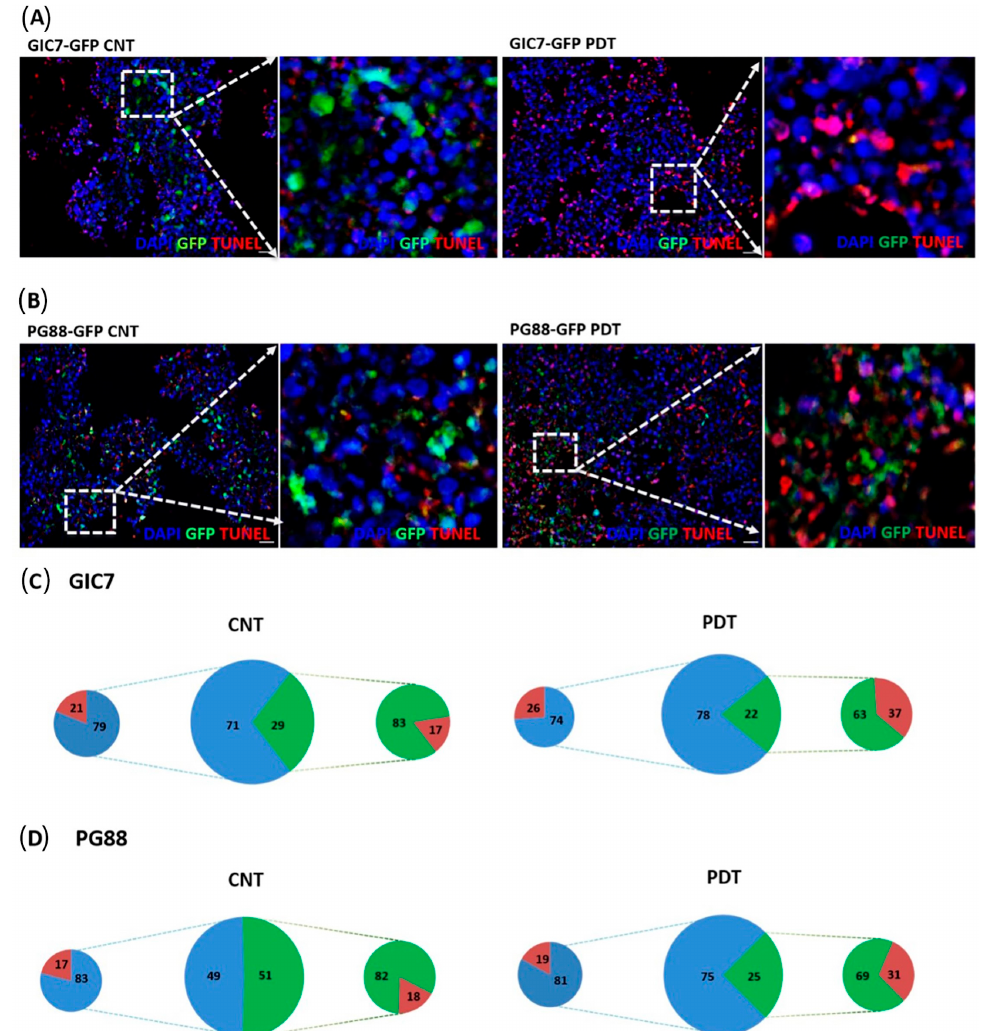
Figure 9. Tunel analysis of GFP-GICs and organoid co-culture. Tunel of GIC7-organoid co-cultures ( A ) and PG88-organoid co-cultures with 5-ALA ( B ) no treated (CNT) (left panels) or treated (right panels) with photodynamic therapy (50 µg/mL with 5-ALA, 1.2 J/cm 2 irradiation). At 20× (big squares), the scale bar is 20 µ m. 5-ALA controls (GIC7-GFP CNT or PG88-GFP CNT) without PDT and PDT-treated (GIC7-GFP PDT or PG88-GFP PDT) visualizing the red TdT-DIG-rhd cells and apoptotic bodies accumulated more in treated tissue at the tumor areas (green fluorescent cells) than in 5-ALA-controls (blue). Few apoptotic cells were scattered in non-infiltrated brain-organoid tissue (blue) in both 5-ALA-control and PDT-treated co-cultures. Blue DAPI-stained nuclei were used to counterstain cells. Semi-quantitative analysis of samples: GIC7 5-ALA CNT, 12 fields from 2 samples; GIC7 PDT-treated, 19 fields from 3 samples; PG88-5-ALA CNT, 7 fields from 2 samples and PG88 PDT-treated, 17 fields from 3 samples, was done. Semi-quantitative analysis is represented as a percentage average of positive cells on ( C, D ) pictures: green color (GFP-GICs cells), blue organoid cells, and red TdT-DIG-rhd positive cells; comparing controls (left part) and PDT samples (right part). Significant differences between GIC7-5-ALA CNT and GIC7-PDT-treatment ( p = 0.0001) and between PG88-5-ALA CNT and PG88-PDT-treatment ( p < 0.001) were found. ( C ) Cell counts show similar TdT-positive cells in organoid areas surrounding tumors (normal cells) and more TdT-positive cells in treated organoids than untreated samples ( D ).